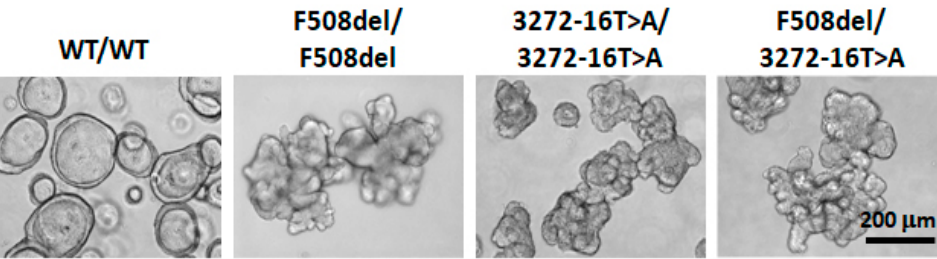
Figure 2. Morphology of intestinal organoids with the genetic variant c.3140-16T>A (3272-16T>A). Organoids obtained from a healthy volunteer (wt/wt) and a patient with the F508del/F508del genotype were used as controls.